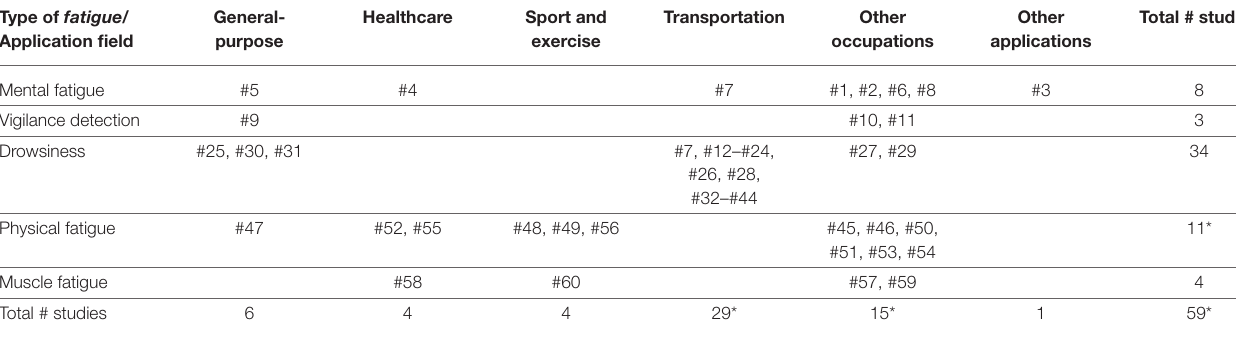
TABLE 2 | Application domain of wearable systems proposed in the included studies according to the concept they